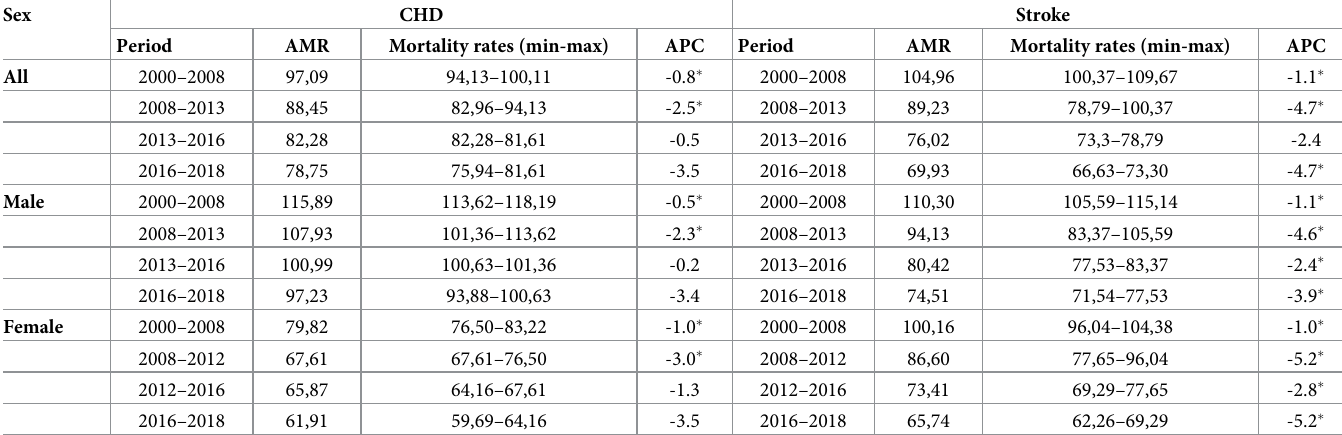
Table 1. Age-standardized CHD and stroke mortality rates per 100,000. Brazil